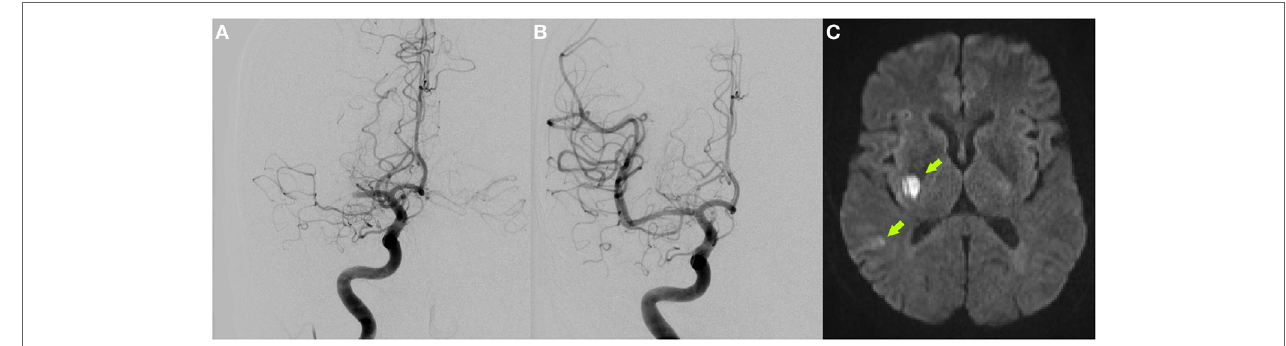
FiGURe 1 | Initial digital subtraction angiography showing right proximal middle cerebral artery occlusion (a) and complete vessel recanalization after successful mechanical thrombectomy (B) . DWI-MRI 4 days after stroke depicts small ischemic infarcts in the right posterior basal ganglia and temporal cortex [arrows (C)